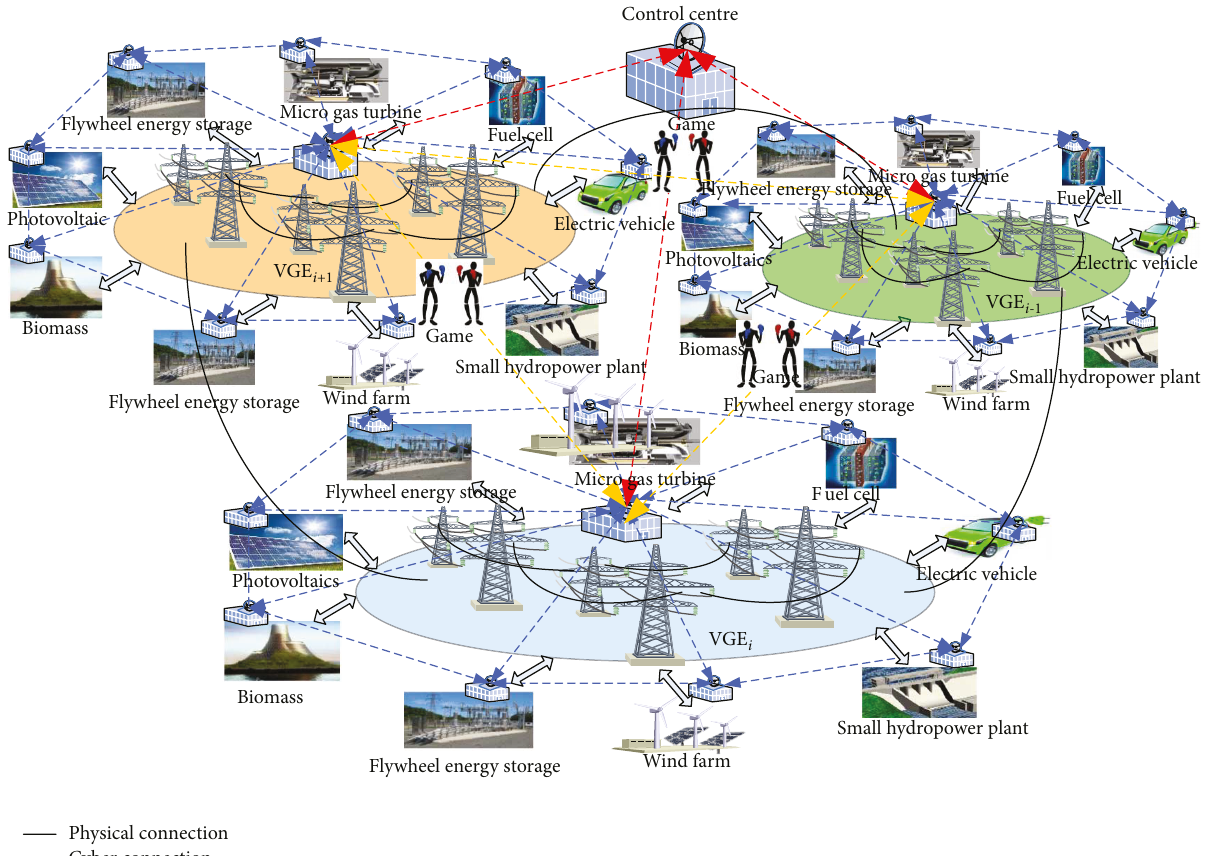
Figure 1: AGC control framework based on HDC structure for the islanded smart